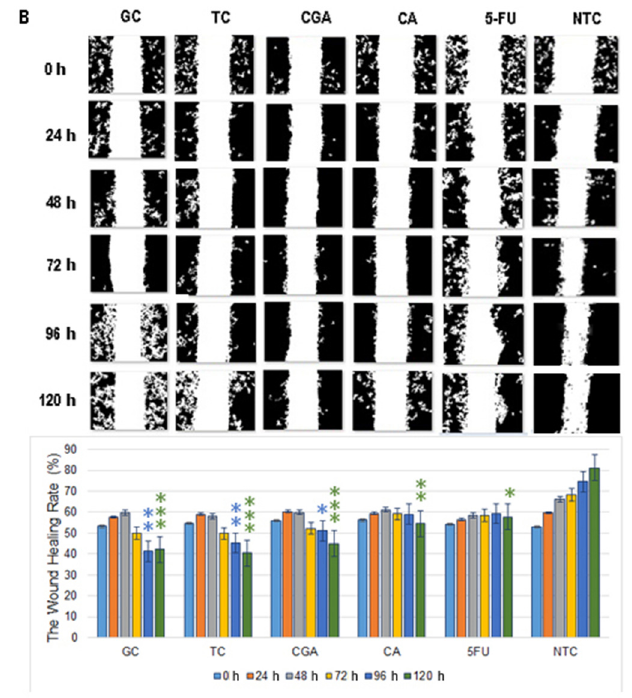
Figure 6. Migration patterns of SW480 ( A ) and SW620 ( B ) cell lines were evaluated by wound healing assay. Cell migration was observed in an inverted microscope (10 × magnification) at intervals of 24 h during 120 h. The quantitative analysis of cell migration in each group: from left to right 1, (GC), 2 (TC), 3 (CGA), 4 (CA), 5 (5-FU) and 6 (NTC) non-treated cells. Values are expressed as mean ± SEM of three independent experiments. Two-way ANOVA, the difference to non-treated cells, * p ≤ 0.05, ** p ≤ 0.01, *** p ≤ 0.001.